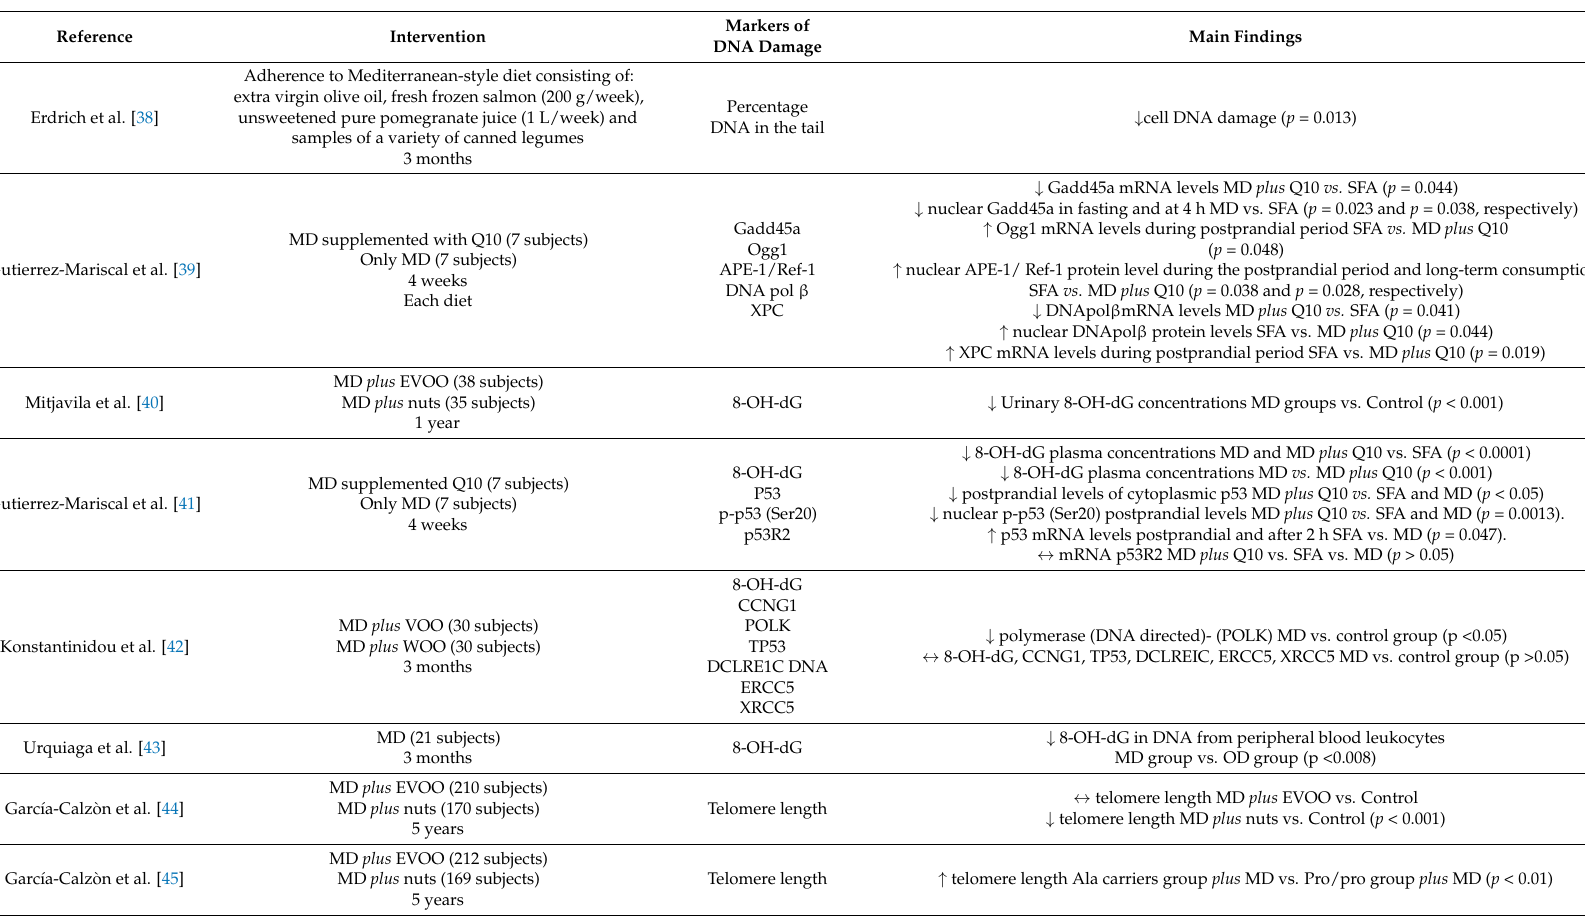
Table 2. Main findings about the role of Mediterranean diet in the modulation of markers of DNA damage, DNA repair, and telomere